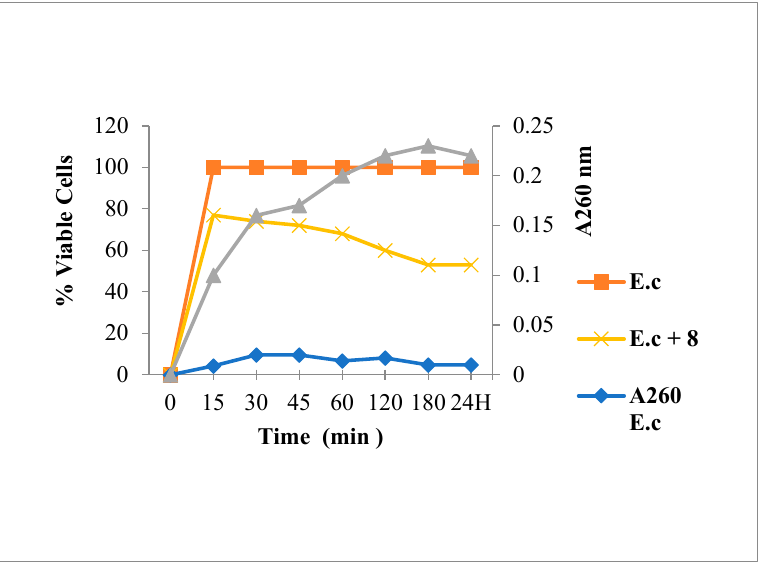
Figure 8. 260 nm absorbent material release and E. coli viability following Chalcone 4 treatment.